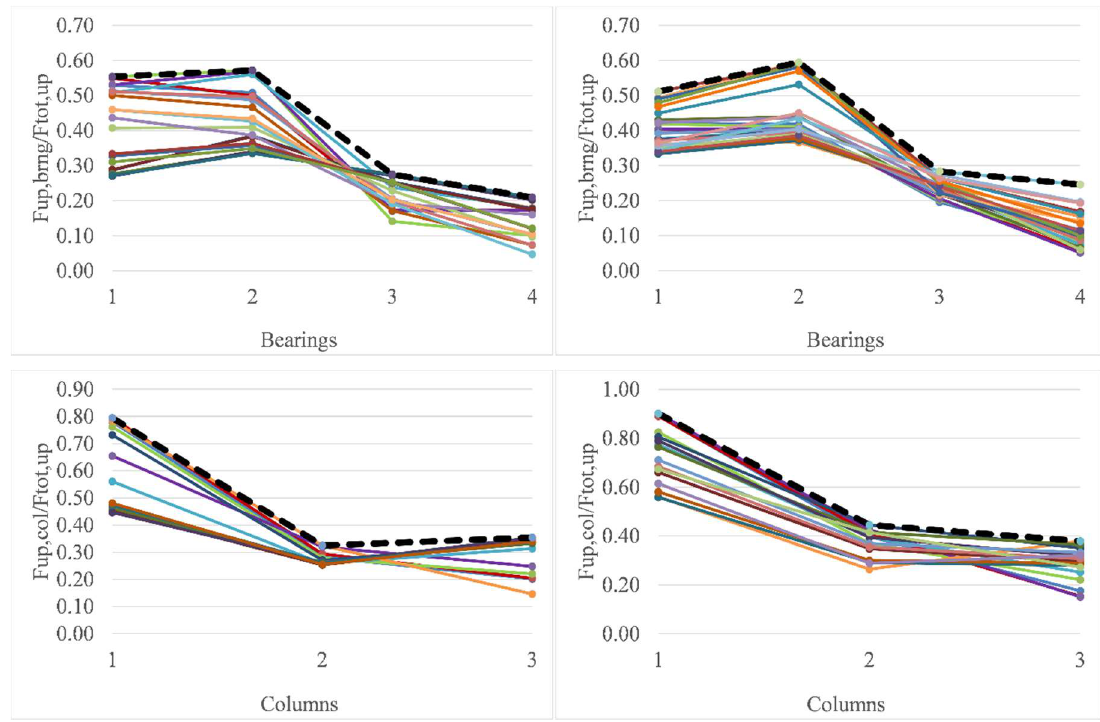
Figure 17. Maximum normalized uplift forces in bearings ( top ) and columns ( bottom ) of the deck with cross-frames, for all the solitary waves ( left ) and bores ( right ) tested in the flume.